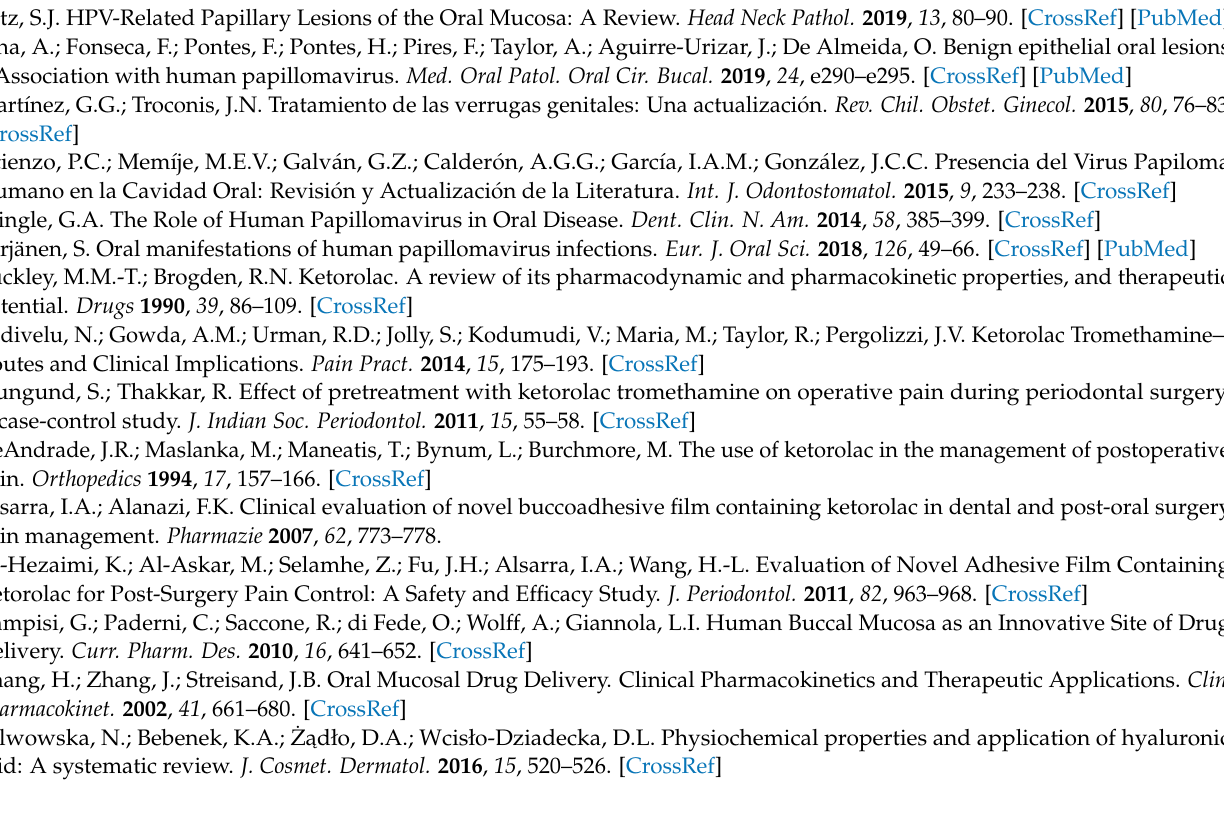
The resulting pH was